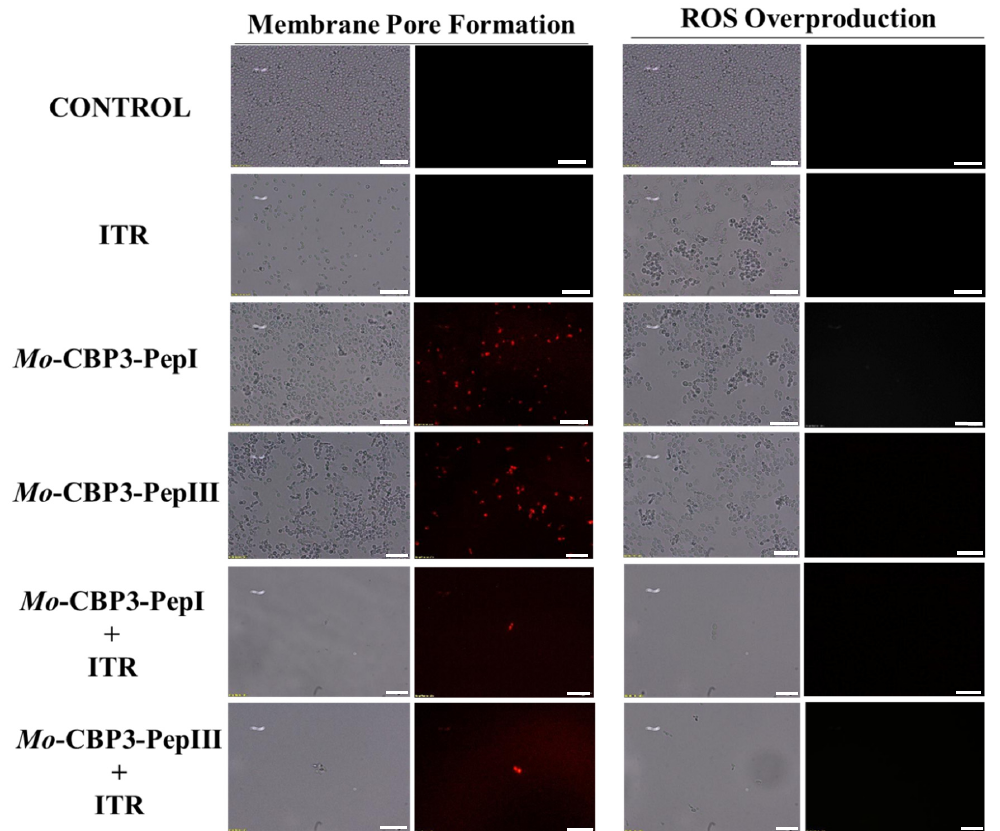
Figure 6. Fluorescence images showing membrane pore formation and ROS overproduction on inhibition of the biofilm of C. parapsilosis cells. Control solution of DMSO-NaCl, treated with Mo -CBP 3 -PepI and Mo -CBP 3 -PepIII at 50 μ g mL − 1 and synergistic activity of both peptides with ITR. Membrane pore formation was measured by the PI uptake assay, and ROS overproduction was detected using 2 ′ , 7 ′ dichlorofluorescein diacetate (DCFH-DA). Bars: 100 μ m.